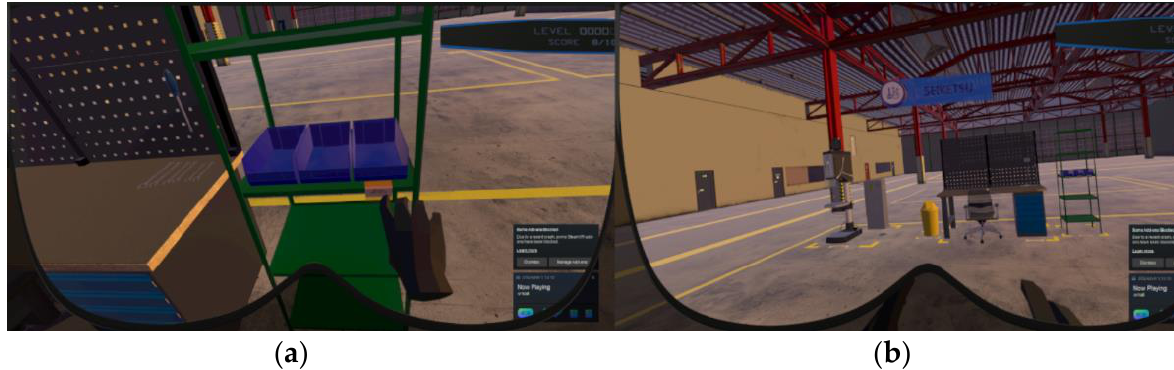
Figure 7. Level 4—( a ) elements of visual management for shelves ( b ) elements of visual manage- ment on the floor.